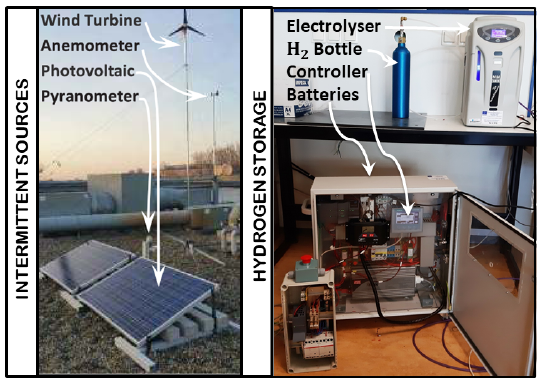
Figure 19. Experimental platform of the PEM electrolyser running on intermittent sources.